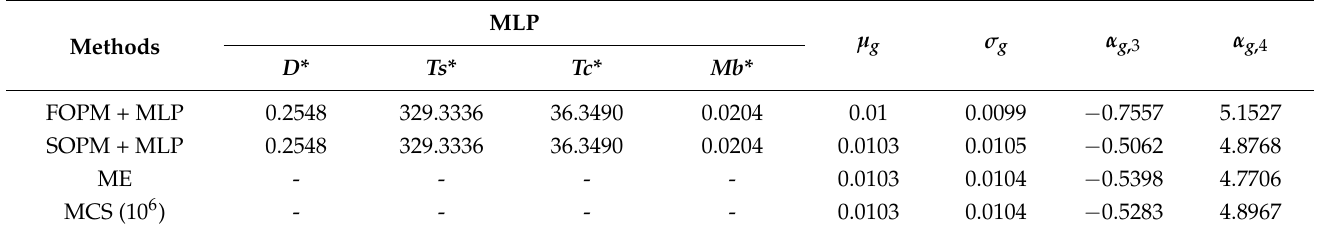
Table 4. MLP and the first four statistical moments calculated by the different methods for Example 2.